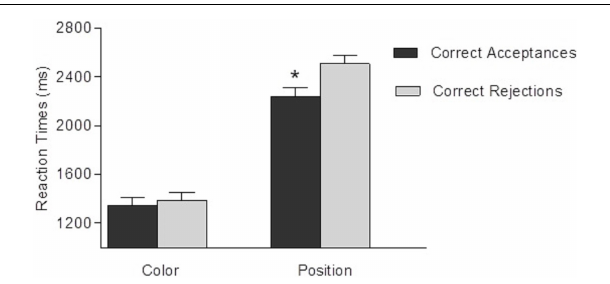
FIGURE 5 | Mean of reaction times for correct choice, as a function of Criteria (Color vs. Position) and Decision Type (Hits vs. Correct Rejections). Error bars represent the standard deviations. Simple * p -value =